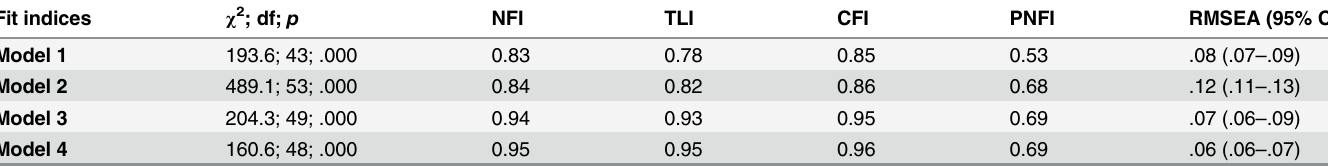
Table 4. Summary of fit statistics of the specified models (n = 574). Fit indices